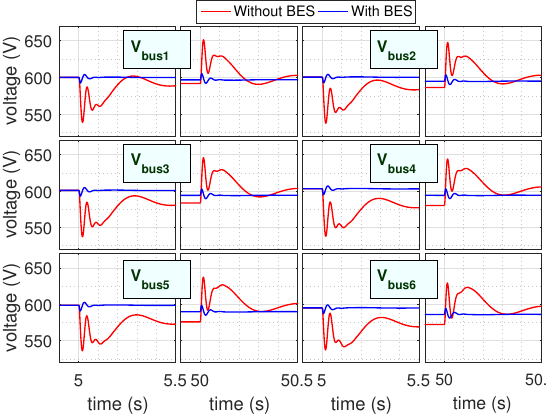
Figure 15. Dc system voltages due to the abrupt PV disturbances.